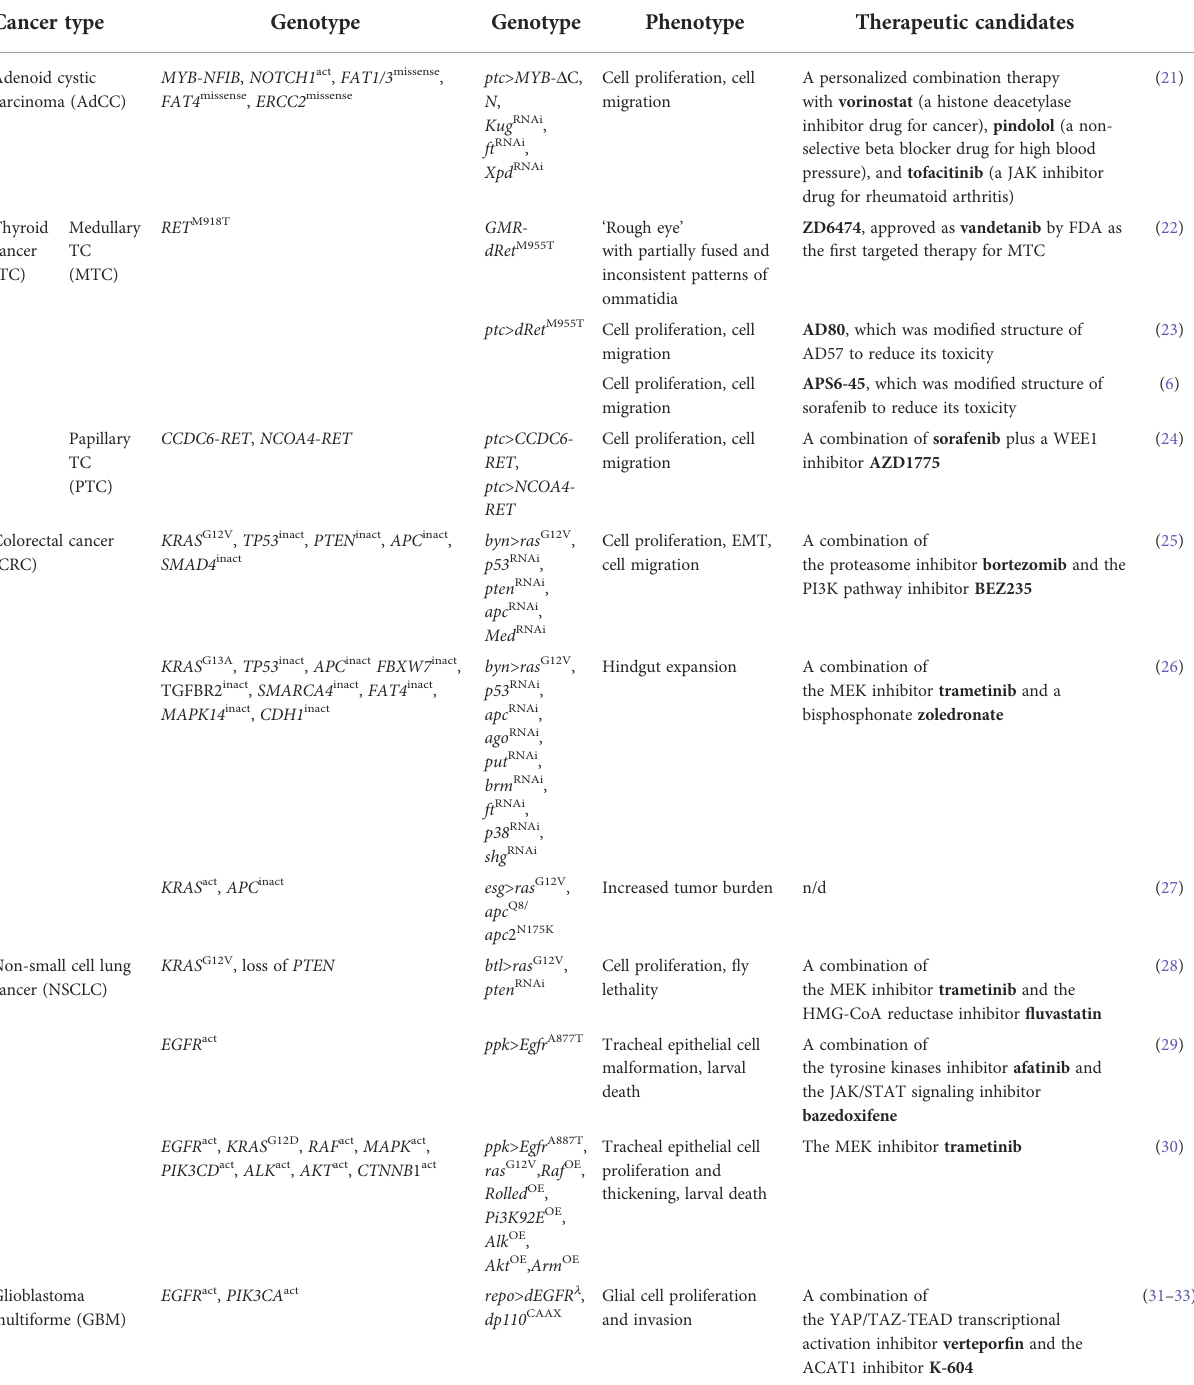
TABLE 1 Drosophila models of various cancer genotypes and drug development using these strains. Patient